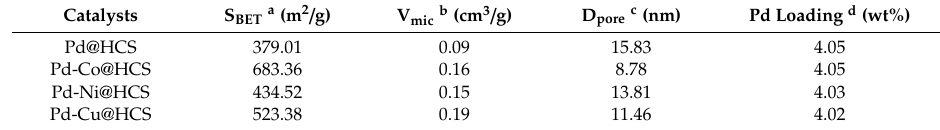
Figure 3. N 2 adsorption–desorption of Pd@HCS and Pd-M@HCS. ( a ) Isotherm adsorption line; ( b ) pore size distribution. Table 1. Textural properties and Pd loading of the prepared samples.